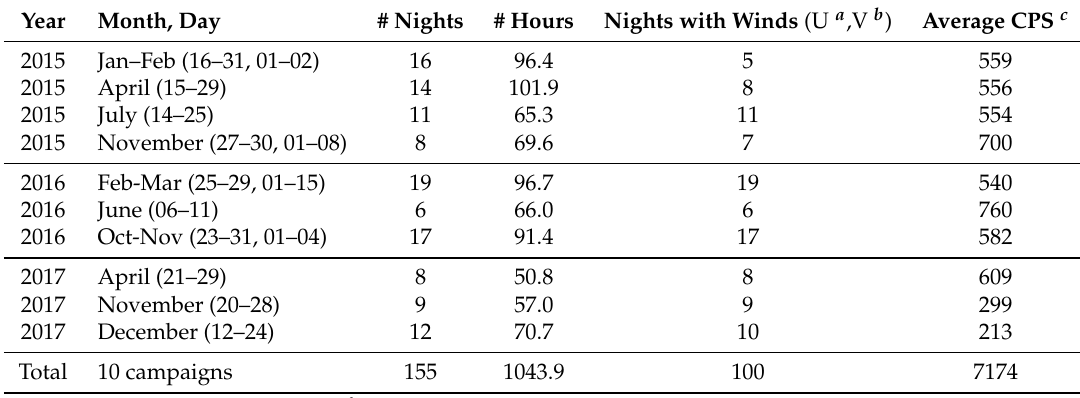
Table 3. Lidar dataset for each operation period being covered by the image acquisition at ALO.